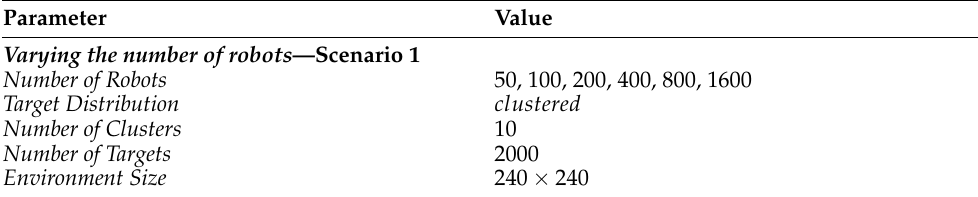
Table 1. Simulation scenarios